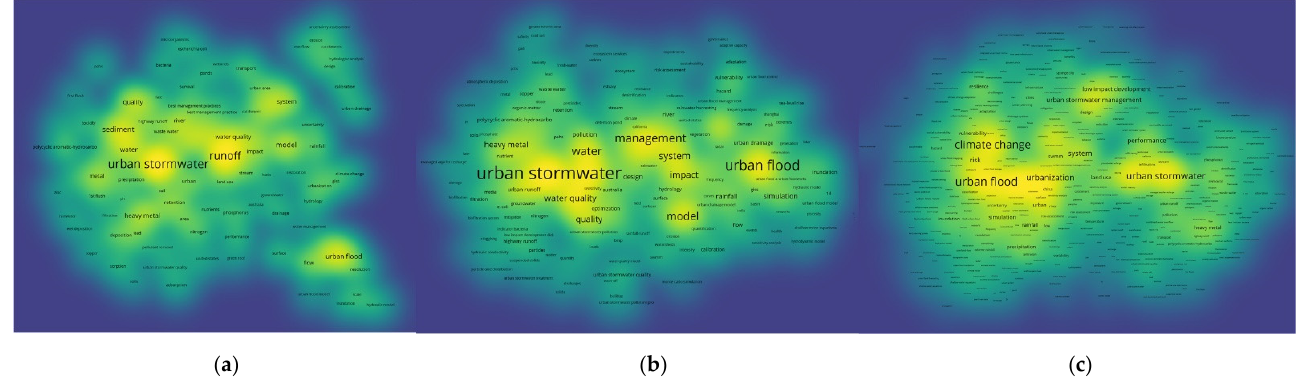
Figure 12. The density maps of the three stages’ keywords: ( a ) 2006–2010; ( b ) 2011–2015; ( c ) 2016–present.